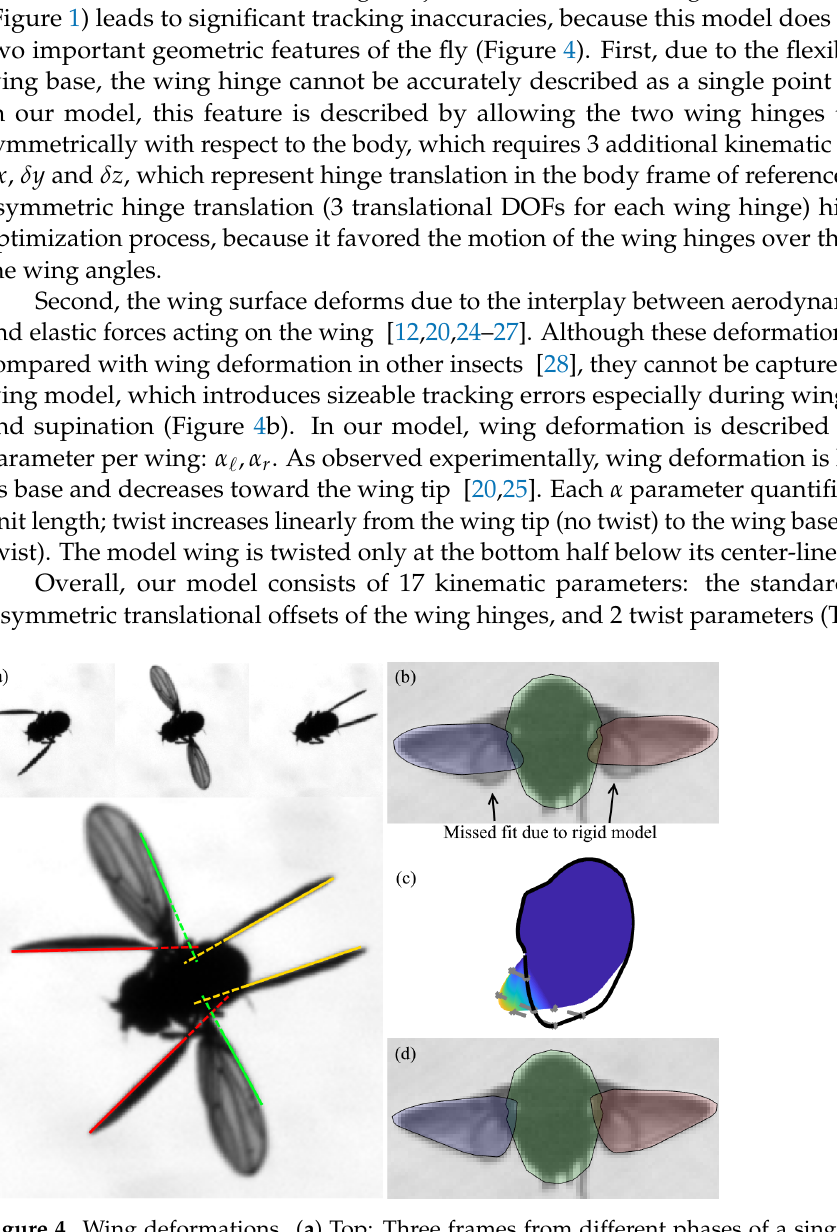
Figure 4. Wing deformations. ( a ) Top: Three frames from different phases of a single wing beat. Bottom: Superimposing the 3 frames shows that the wing hinge is effectively not fixed during the stroke. The solid lines marking the leading edge of the wing do not intersect at a single point (dashed lines). ( b ) An unsuccessful fitting attempt using a rigid wing on a frame with a twisted wing during supination. ( c ) Wing deformation used in our 3D model. Color represents deformation level, and the black line shows the rigid wing outline. ( d ) A successful fit using a flexible